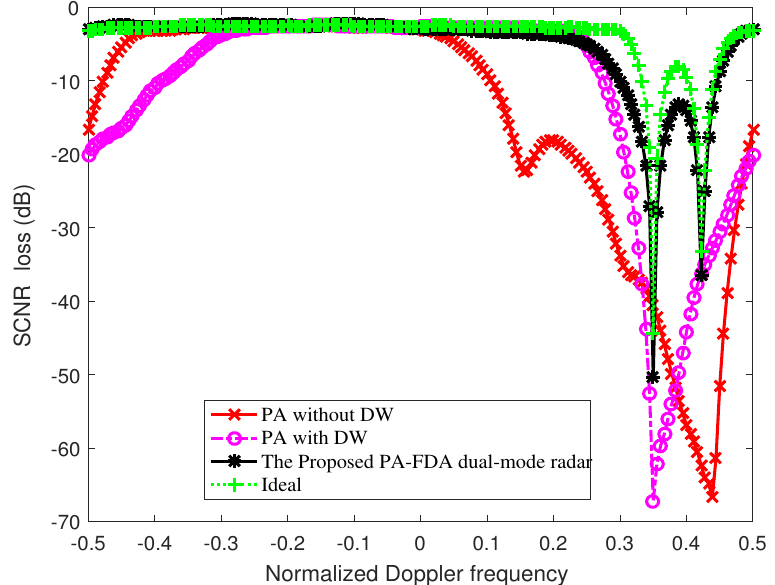
Figure 8. SCNR loss versus normalized Doppler